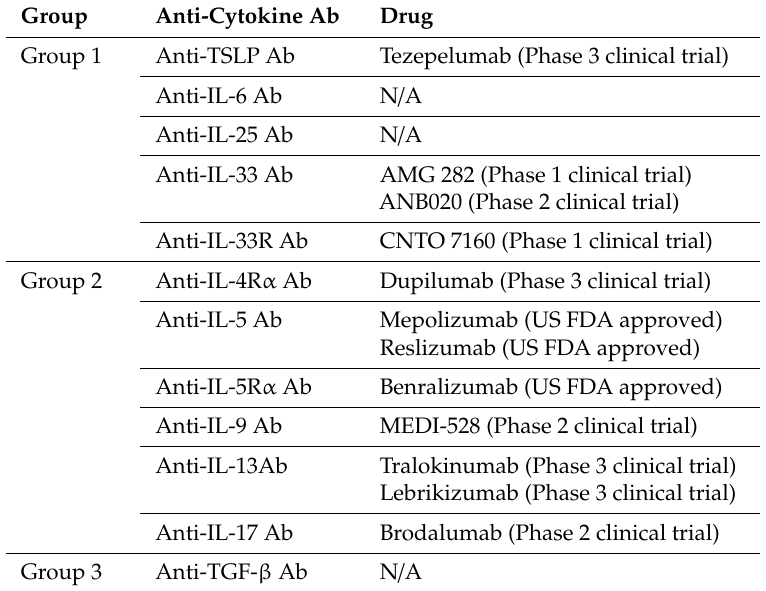
Table 1. Recent clinical and investigational anti-cytokine Ab for asthma